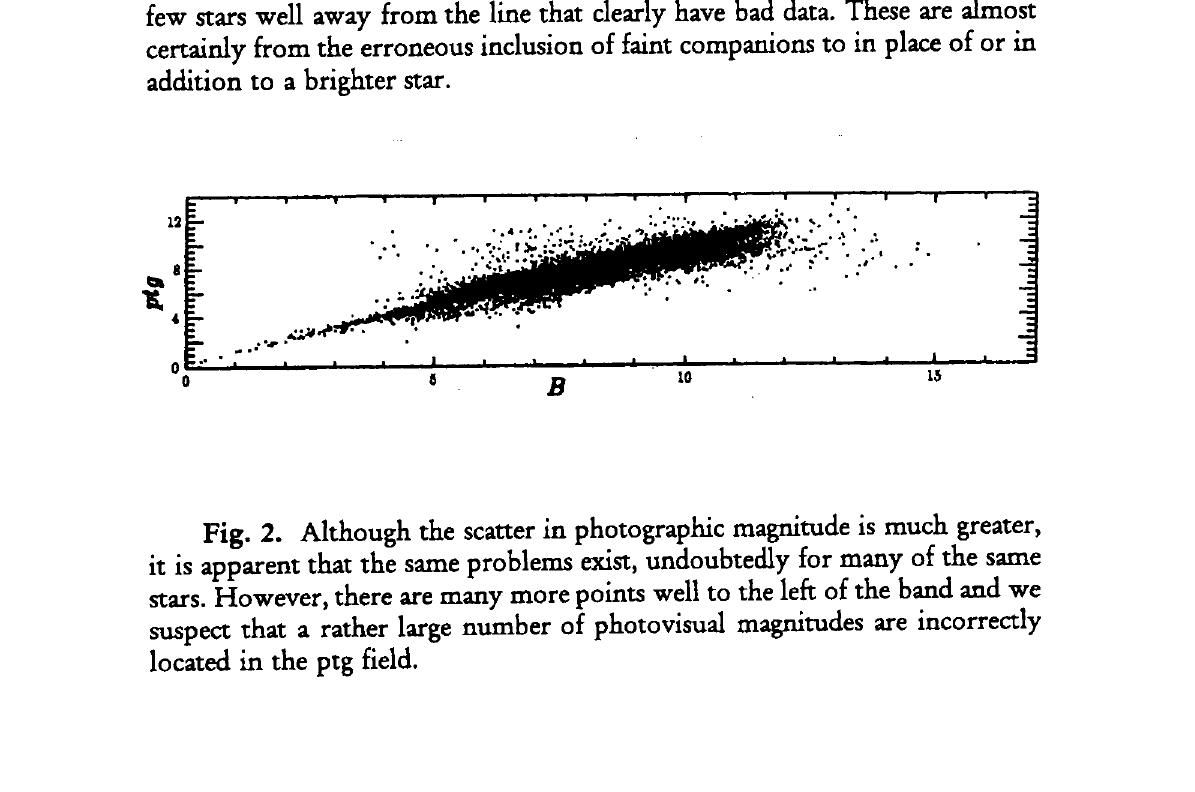
Fig. 1. A comparison of photoelectrically determined V magnitudes with older photovisual data from catalogs such as the HD and SAO. Since photoelectric UBV observations are not available for 80 percent of SKYMAP stars, ptv and spectral data must be used to derive approximate values of